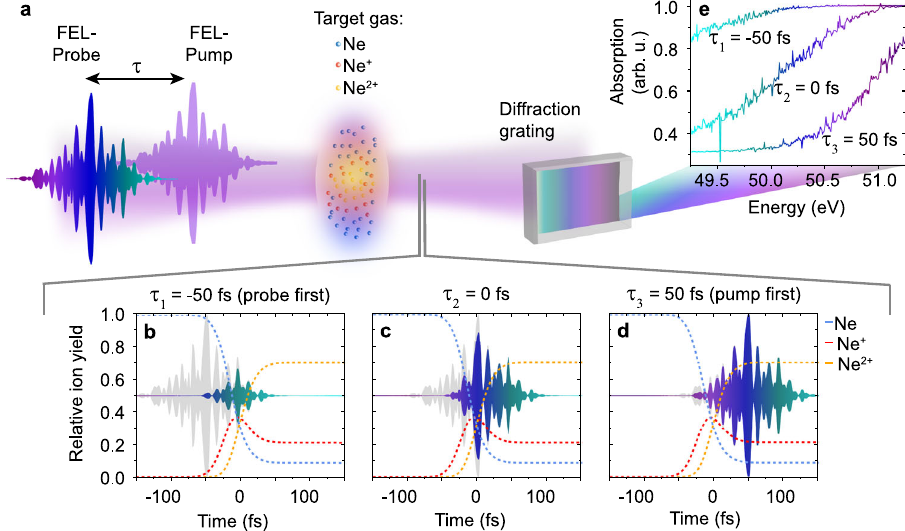
Fig. 1 Principle of frequency-resolved plasma gating. a Measurement scheme using XUV double ionization of a neon gas target [depicted by blue, red, and yellow spheres, respectively indicating neutral neon (Ne), and its singly charged (Ne + ) and doubly charged (Ne 2 + ) ions] for frequency-resolved gating of a chirped XUV-FEL probe pulse. This leads to a time-delay-dependent change of the probe-pulse absorption spectrum measured with a diffraction grating. b – d Averaged time-dependent relative atomic/ionic population of Ne, Ne + , and Ne 2 + calculated using 50-fs SASE pump pulses 24 with, on average, 4 × 10 13 Wcm − 2 peak intensity. The transmitted (gated) temporal pulse pro fi le of a chirped SASE probe pulse and the respectively passed frequency band are illustrated by violet, blue, and green-colored SASE “ spikes ” (different frequency components are represented by different colors) for three different time-delay settings: τ 1 = − 50 fs (probe fi rst), τ 2 = 0 fs (pump-probe pulse overlap), τ 3 = 50 fs (pump fi rst). In gray color, the gated probe-pulse pro fi les are depicted, attenuated through absorption in the initially abundant Ne and Ne + target species. e Corresponding transient absorption spectra showing a delay-dependent modi fi cation of the absorption (or gate) band for varied time delays ( τ 1 , τ 2 , and τ 3